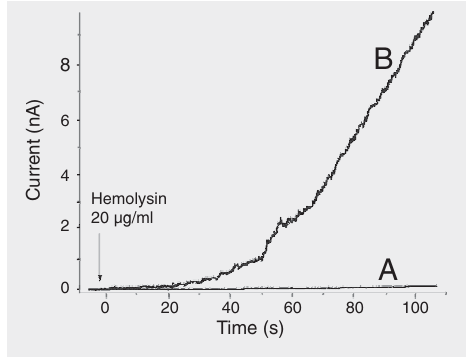
Figure 4. Influence of liposomes on the hemolytic activity of the Passiflora quadrangularis hemo- lysin. The hemolysin was pre- incubated with liposomes as de- scribed in Material and Methods.